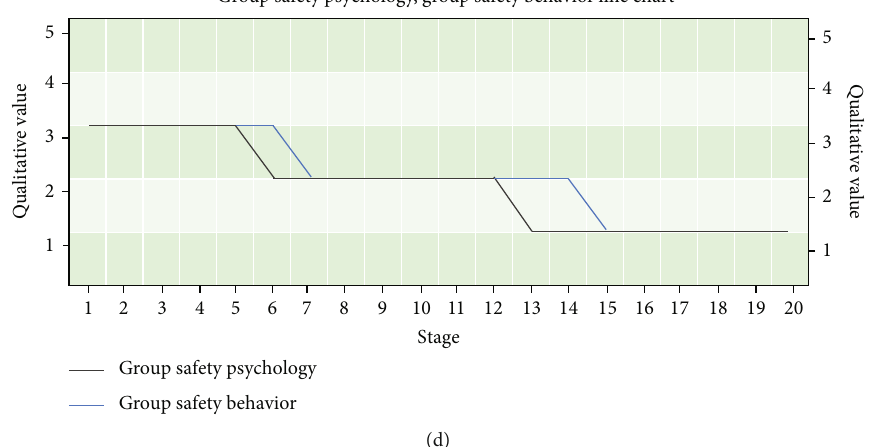
Figure 10: Simulation results and comparative analysis diagram of Scheme 2. (a) Simulation result statistics. (b) Trend chart of group safety psychological change. (c) Trend plot of group safety behavior change. (d) Plot of comparison of trends in group safety psychology and behavior